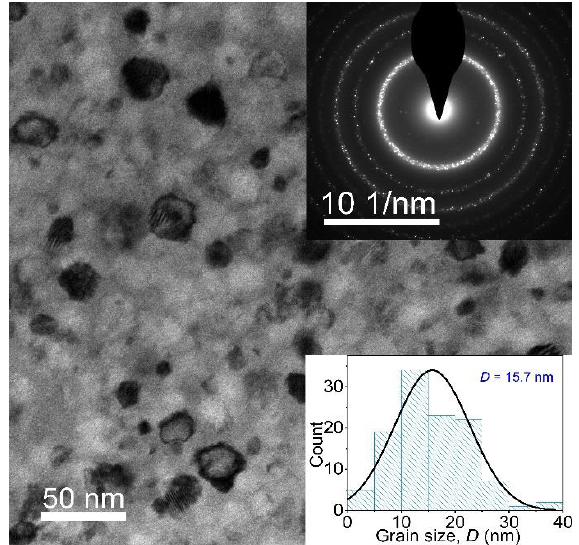
Figure 4. TEM bright field images with the corresponding selected area electron diffraction patterns and grain size distribution for the annealed Ge2 alloy ribbons.